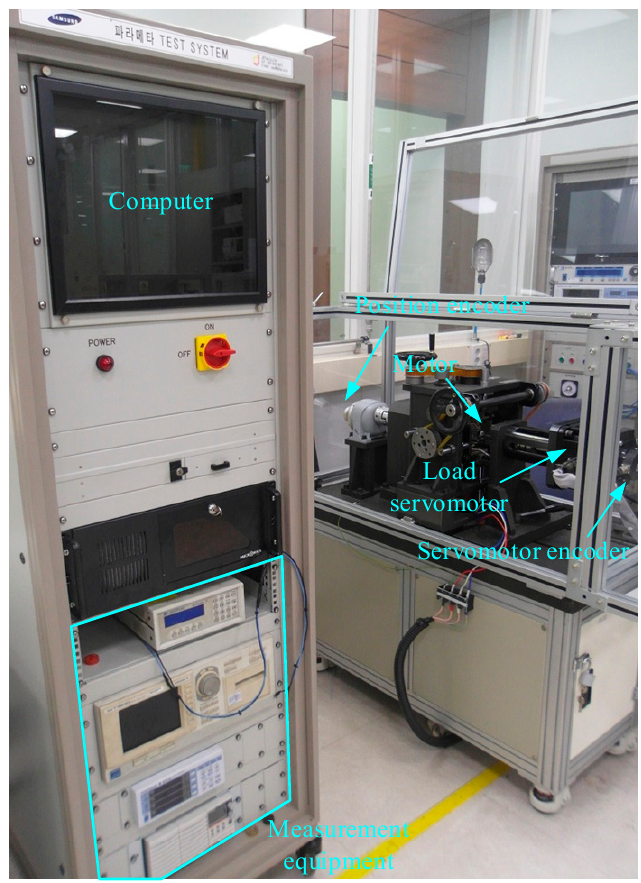
Figure 7. Experimental setup.